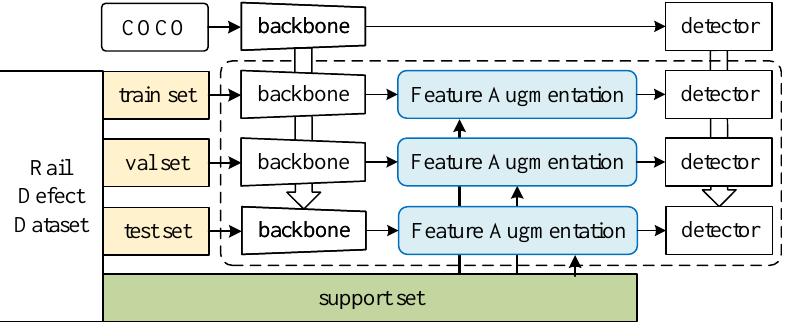
Figure 5. Demonstration of learning strategy of our detection framework. The backbone is pre- trained on MS COCO, and fine-tuned on the rail defect dataset together with our proposed feature augmentation